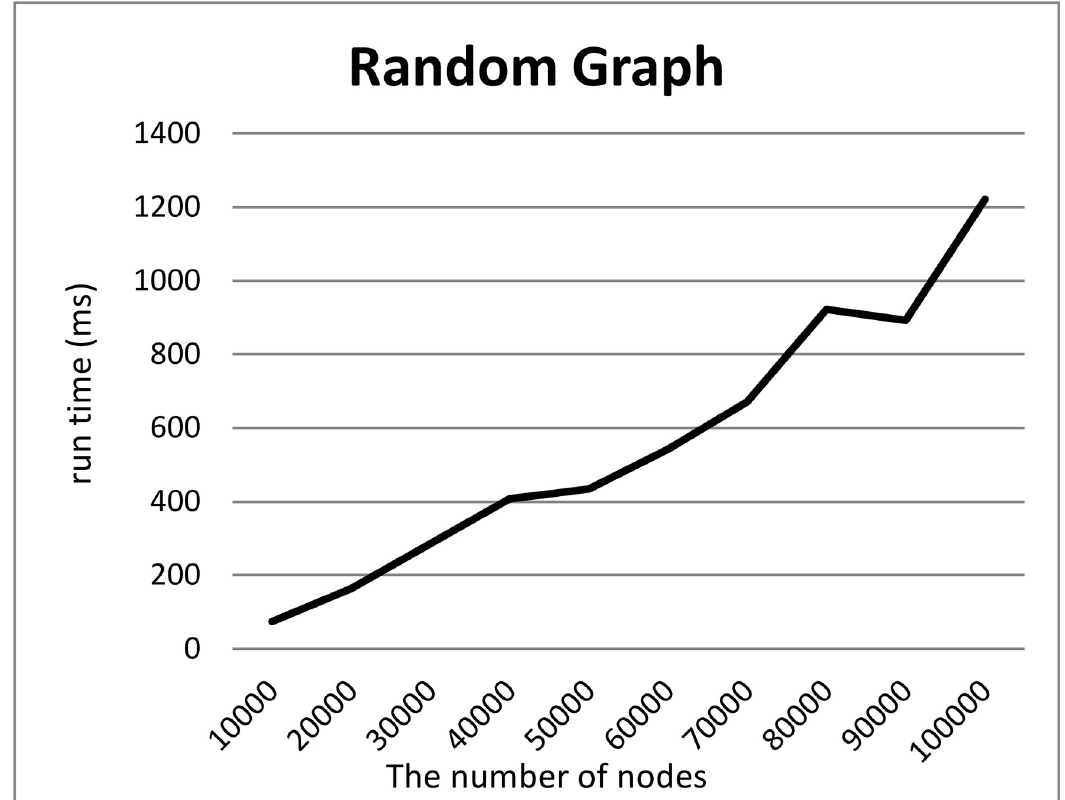
Fig 5. Computation time required to split the dataset generated using the random graph. x -axis and y -axis correspond to the number of nodes and the average of running time [ms].